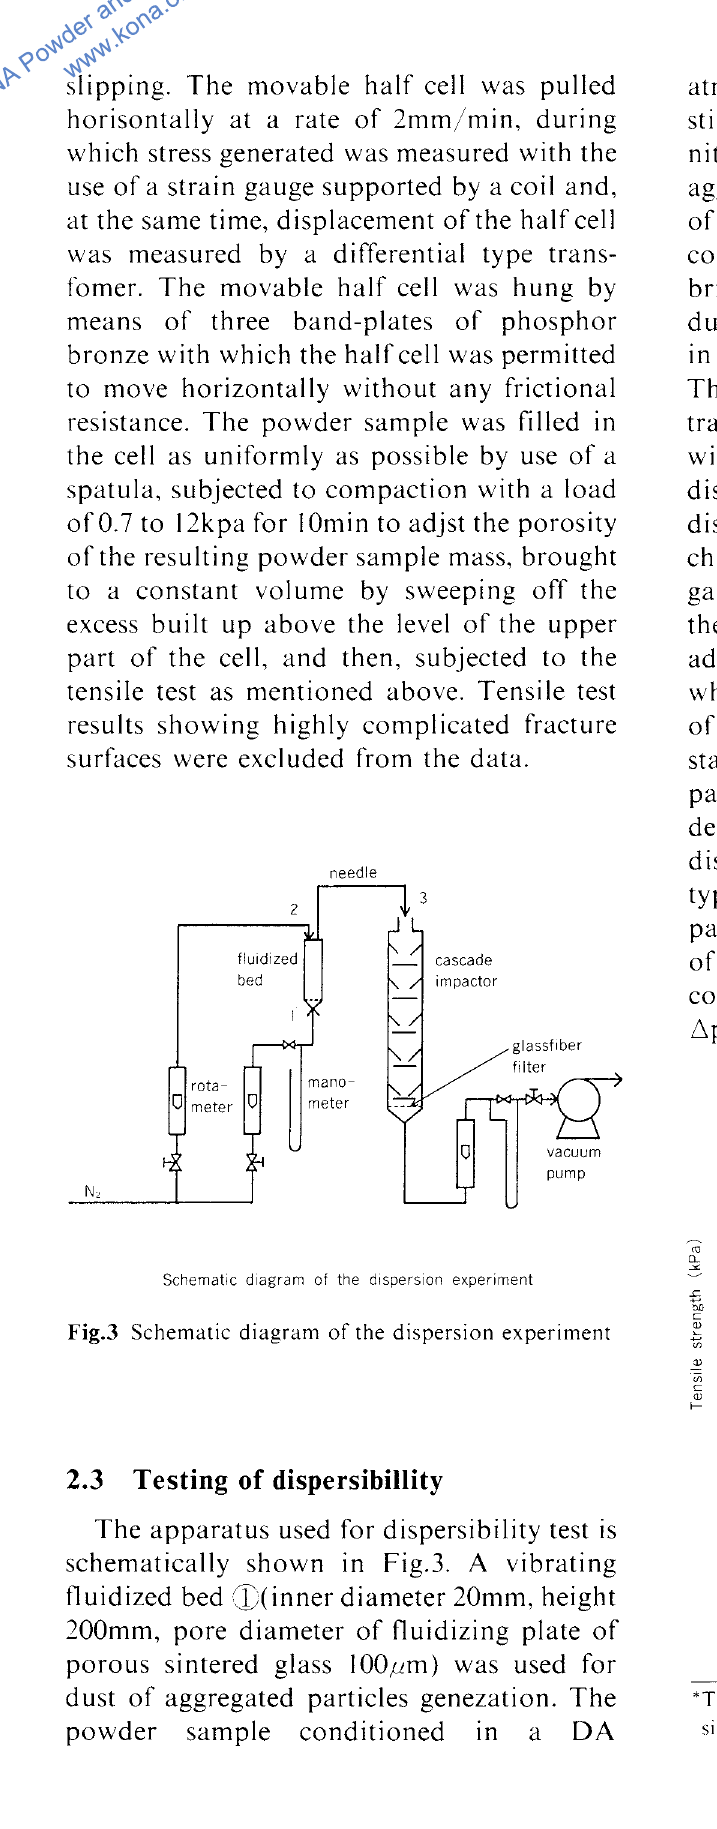
Fig. 4 Tensile strength of the limestone po\\der exposed to various humidities *This type of cascade impactor can measure the particle size of aggregated